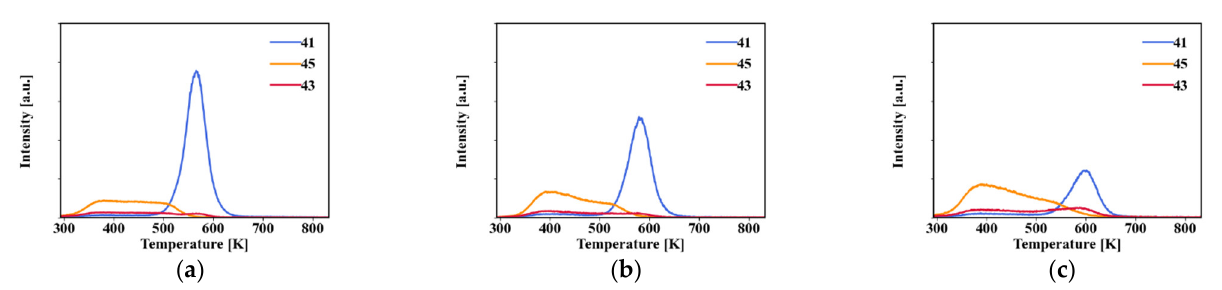
( c ) Figure 3. TPD data for the reaction of THF on ( a ) ZrO 2 ( b ) 1 wt% Na-ZrO 2 ( c ) 2 wt% Na-ZrO 2 : THF- m/e 72; 1,3-butadiene-m/e 54.